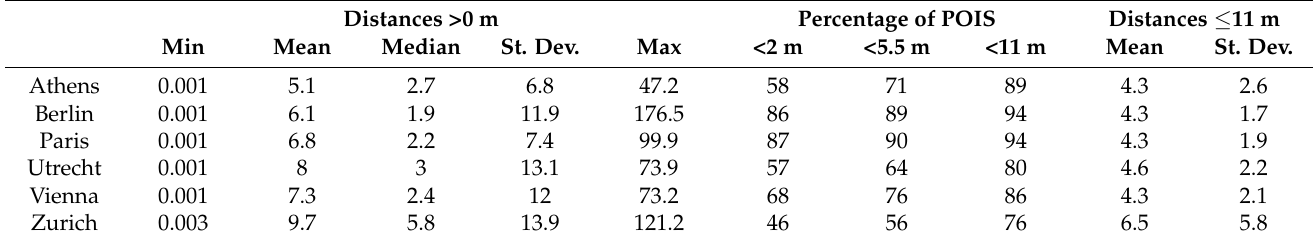
Table 6. Statistics for POI distances from the building border (Check